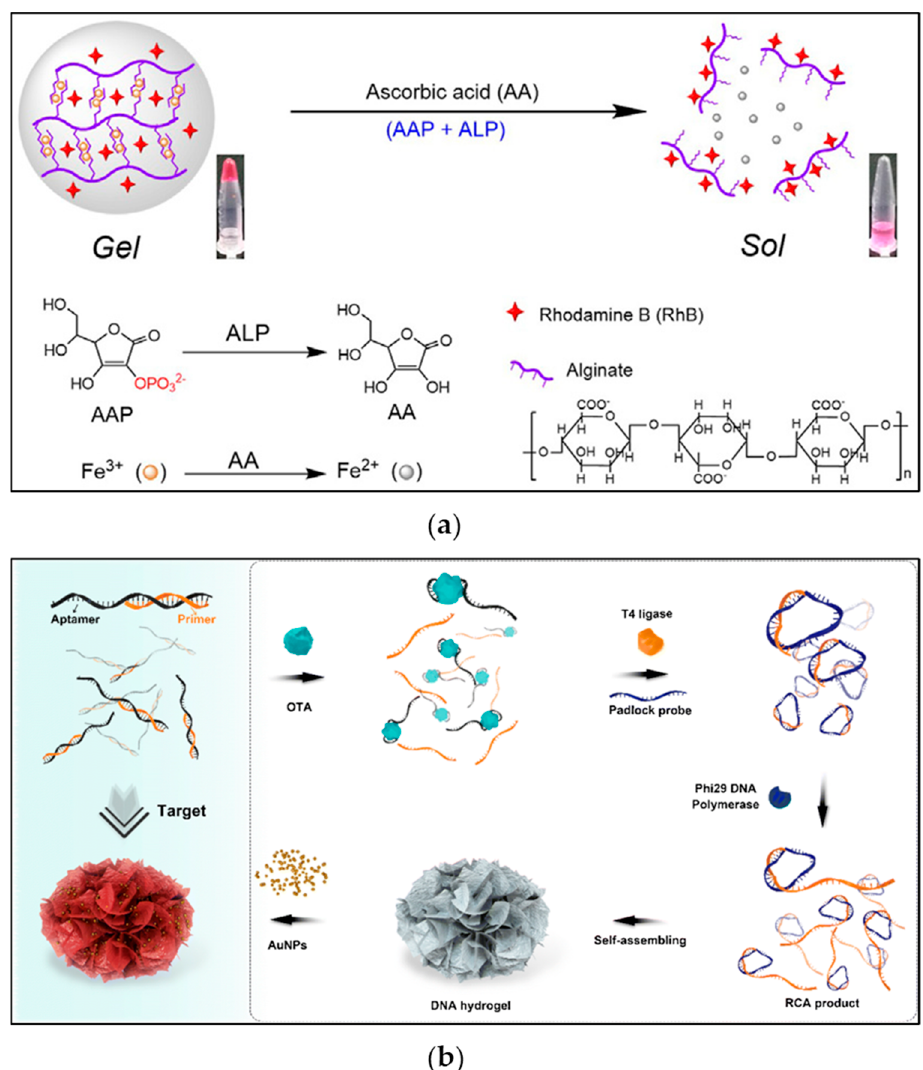
Figure 3. Schematic illustration of hydrogels’ transition signal conversed into colorimetric signal. ( a ) The AA-responsive alginate hydrogels for the colorimetric detection of ALP; ( b ) The self-assembled DNA hydrogels based on RCA products for the visual OTA detection. Reproduced with permission from Liping Gao ( a ) and Liling Hao ( b ), Analytica Chimica Acta ( a ) and Microchimica Acta ( b ); published by Elsevier ( a ) and Springer ( b ), 2021. Gold nanoparticles (AuNPs) have long been known for their colorimetric detection.